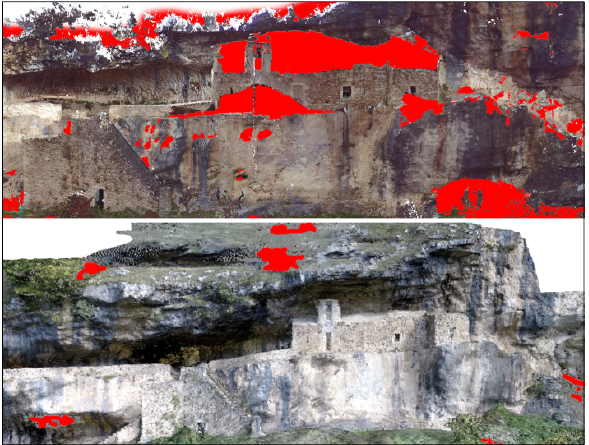
Figure 17. Compare point clouds, in red missing parts